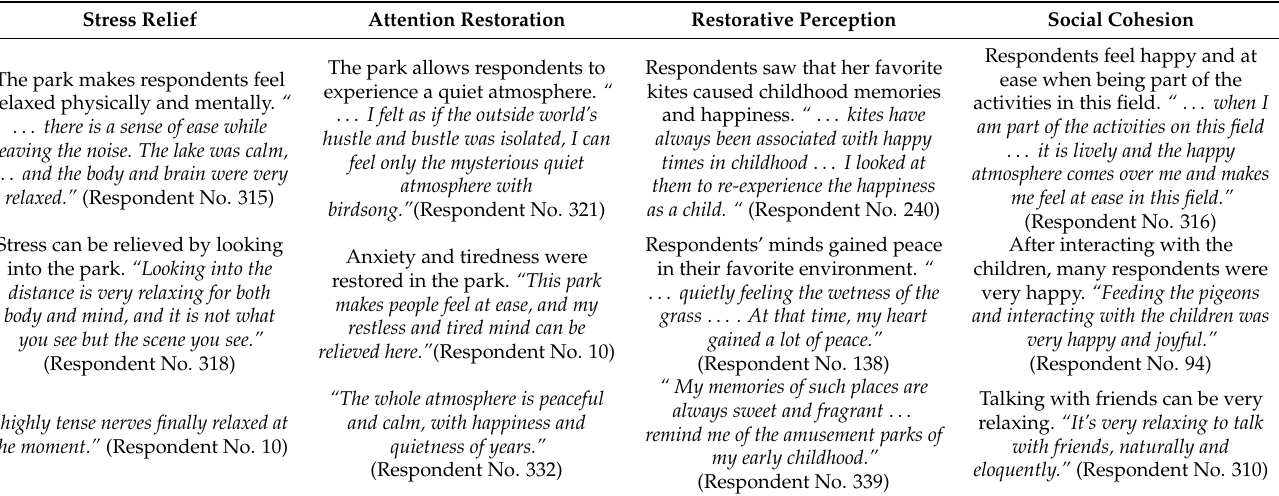
Table 8. Young adults’ place attachment to urban